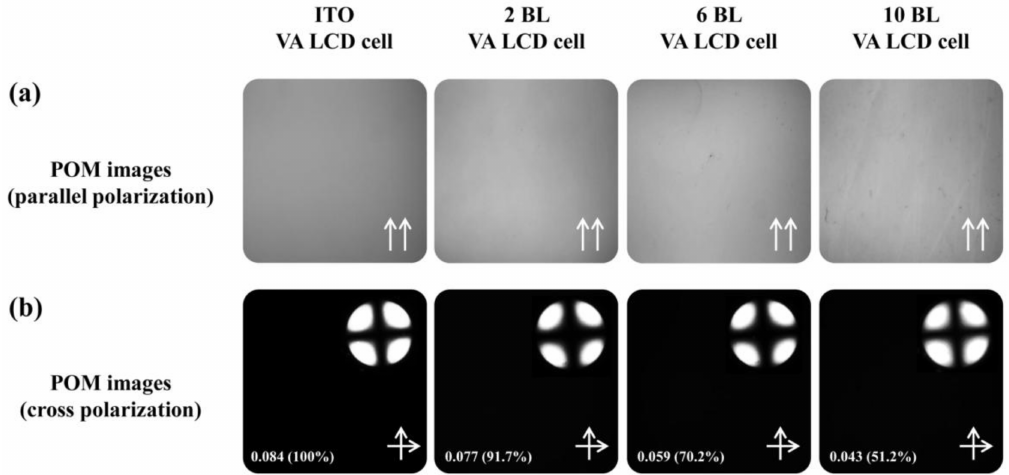
Figure 5. Vertically aligned (VA) LCDs observed by a polarized optical microscope (POM) with crossed polarizers set in two orientations with respect to the LCD cells: ( a ) parallel polarization and ( b ) cross polarization. The inserted values are the transmittances of VA LCD cells under cross polarization using a UV–Vis spectrometer.